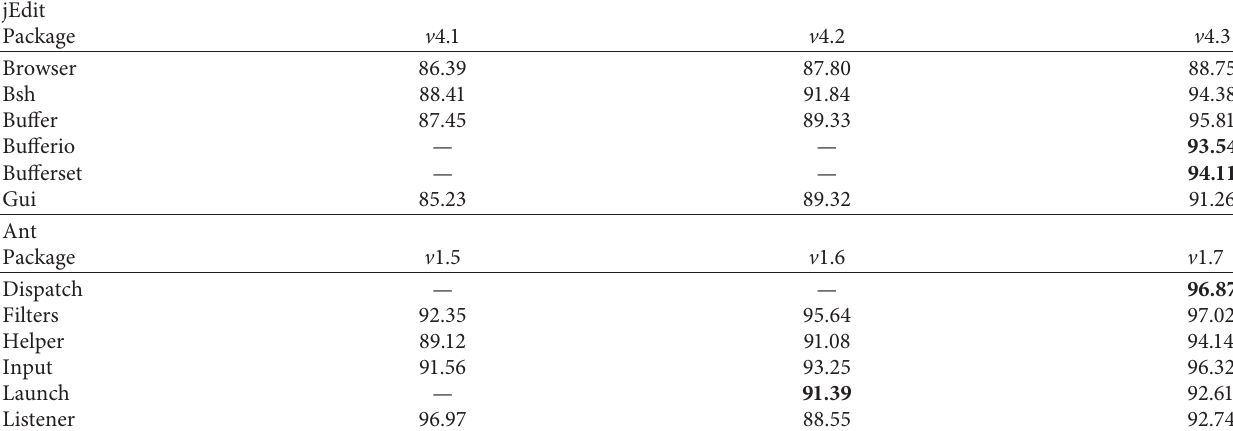
Table 6: Part of the R module values when taking jEdit 4.1, 4.2, 4.3 and Ant 1.5, 1.6, 1.7 as the version to be evaluated,